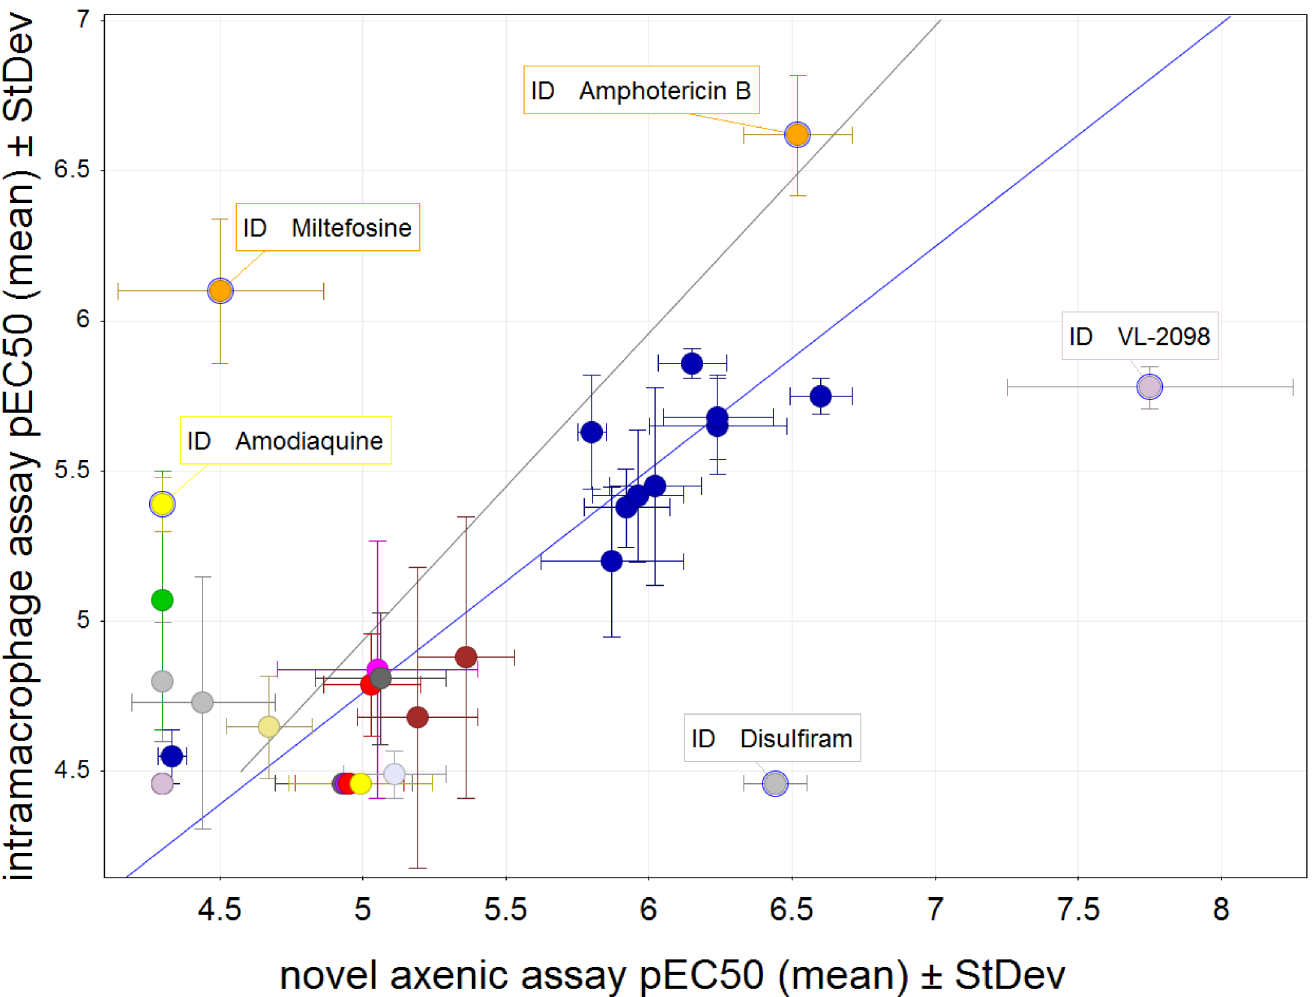
Fig 3. Potency comparison of a series of structurally distinct compounds between the novel axenic and intramacrophage assay. In this scatterplot the mean pEC 50 values for control compounds representing a range of pharmacophores are compared between the novel and intramacrophage assay. Data set represents three or more replicates and the standard deviation is shown with error bars for each assay. Black line shows equipotency between both assays, blue line shows linear regression for compounds that are active in both assay (with outliers miltefosine and VL-2098 excluded, R 2 = 0.81).